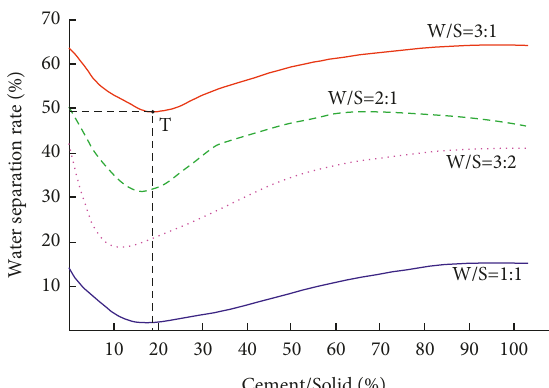
Figure 4: Water separation rate of clay-cement slurry [26, 27] with different water-solid ratios. W/S is the ratio of water to dry materials.